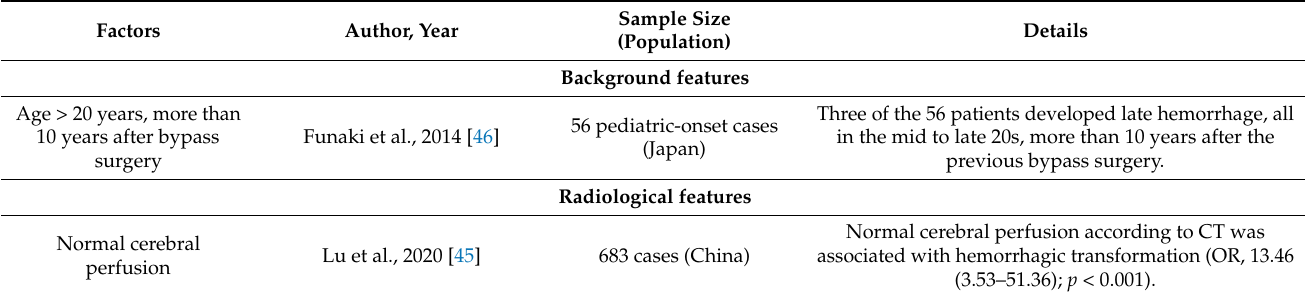
Table 3. Factors associated with hemorrhagic transformation in ischemic onset moyamoya